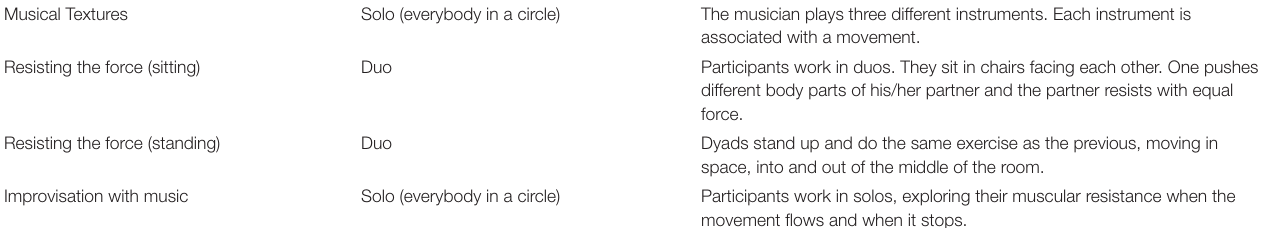
TABLE 1 | Description of activities within the session (Motta-Ochoa et al., 2021). Musical Textures